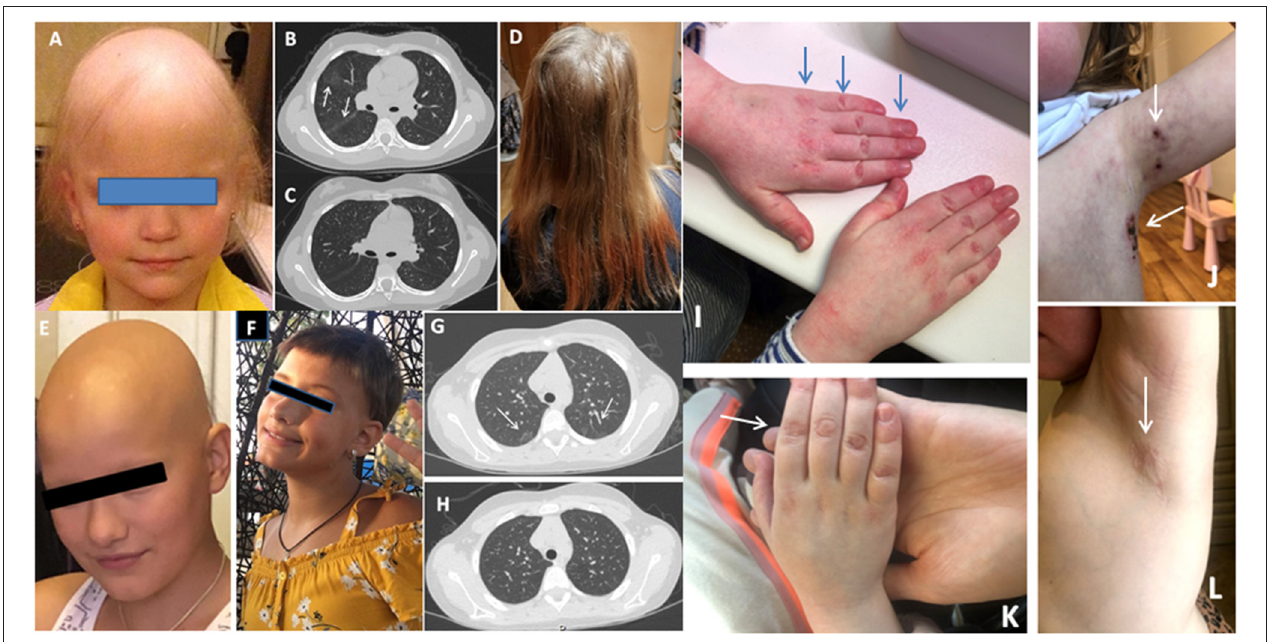
FIGURE 1 | (A) Alopecia in JIA2 patient (before tofacitinib); (B) Chest CT from patient JIA2 (interstitial thickness and ground-glass opacities - arrows); (C) Chest CT from patient JIA2 following 3 years of tofacitinib therapy (resolution of interstitial thickness and ground glass opacities); (D) Hair growth in JIA2 patient (3years on tofacitinib); (E) Alopecia in patient JIA10 before tofacitinib treatment and after 6 months of treatment (F) ; (G) Ground-glass opacities in patient JDM1 before tofacitinib (arrows) and 2 years on tofacitinib (H) ; (I) The hands with Gottron papules before tofacitinib treatment in JDM2 patient and the left axillary area (arrows) with necrotizing changes (J) ; (K) the right hand 16 weeks after tofacitinib treatment and the left axillary area (L) after 6 months of tofacitinib treatment of the same patient.